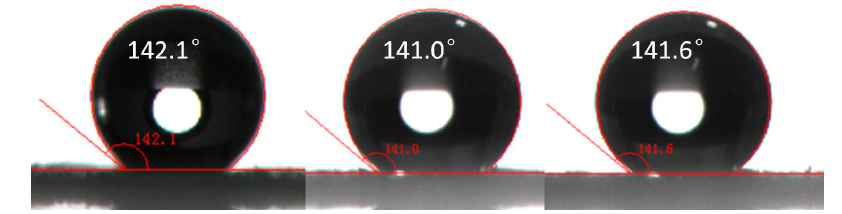
Figure 6. The WCA of verification experiment.